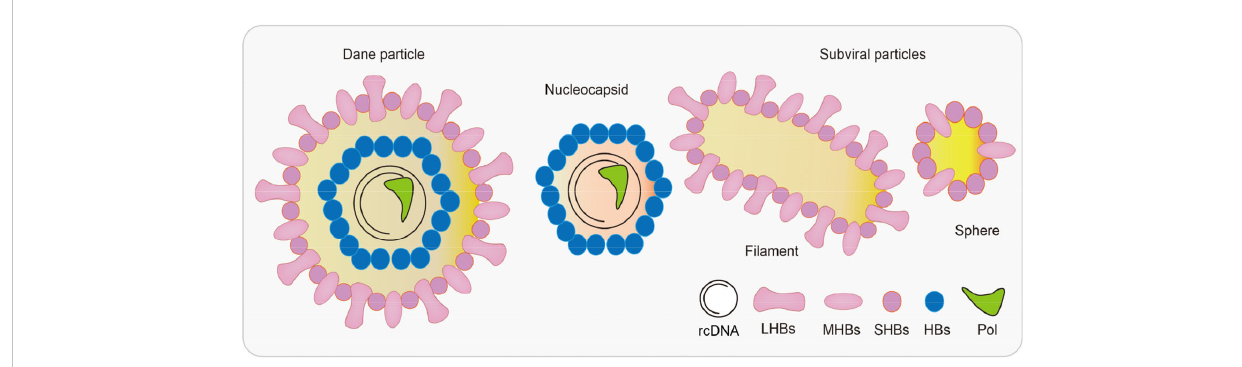
FIGURE 1 Hepatitis B virus (HBV)-associated particles. The diameter of Dane particles is about 42 nm, and their envelopes are made up of large/middle/small HBsAgs (LHBs/MHBs/SHBs). A nucleocapsid contains both viral genomes and polymerases. There are two types of subviral particles: fi laments and spheres. HBV, hepatitis B virus; HBsAgs, hepatitis B surface antigens; LHBs, lipid-embedded large HBsAgs; MHBs, lipid-embedded medium HBsAgs; SHBs, lipid-embedded small